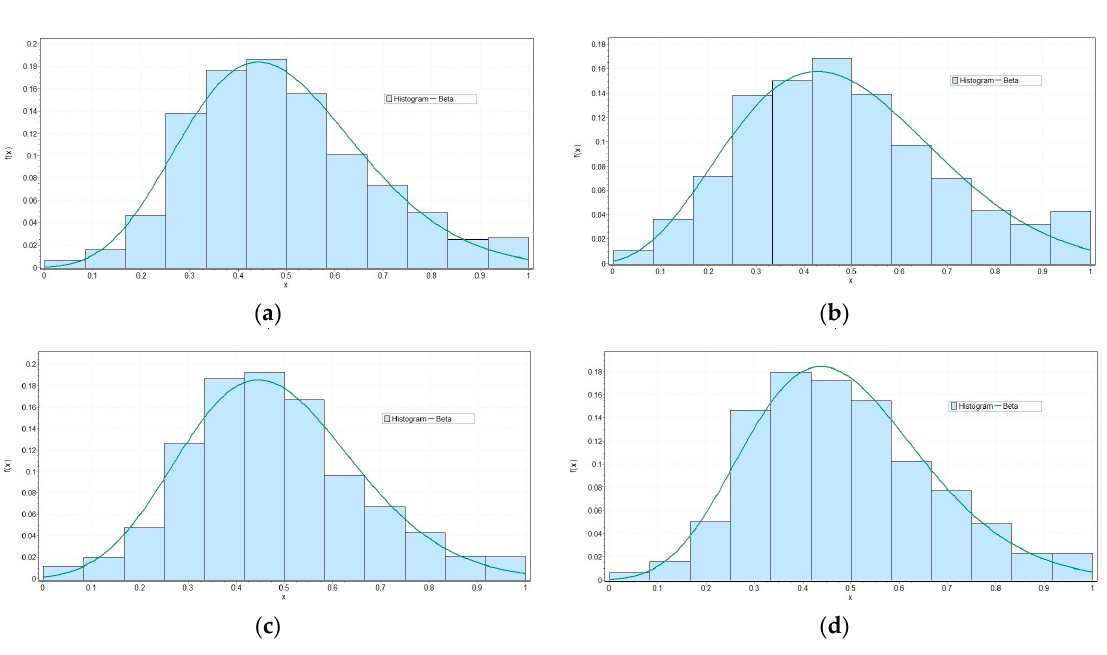
Figure 4. Fitting of the social ( a ); economic ( b ); environmental ( c ); and overall ( d ) vulnerability indices to the beta probability density function.